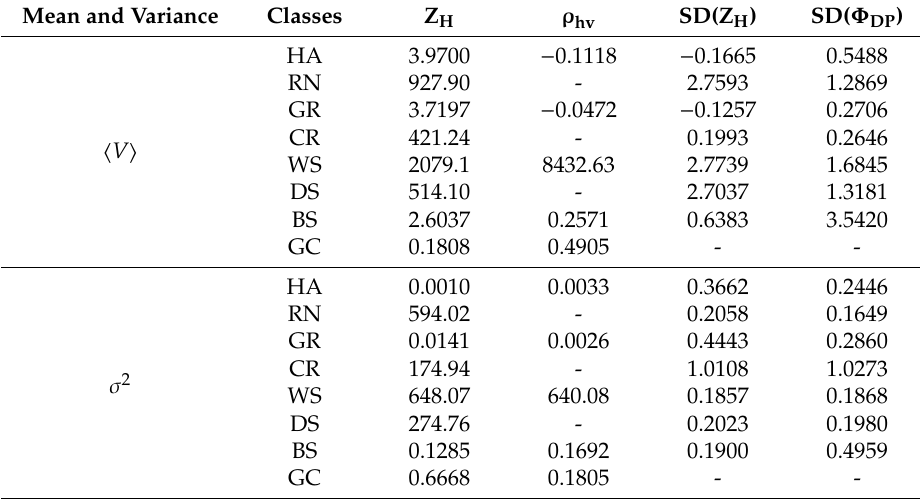
Table 2. Mean (cid:104) V (cid:105) , and variance σ 2 of four variables Z H , ρ hv , SD(Z H ) and SD( Φ DP ) and eight classes in Equations (3) and (4). The en-dash indicates that the fitting function is Equation (5) without mean and variance. Values given are the square (for Equation (3)) and the natural logarithm (for Equation (4)) of Z H [dBZ], Φ DP [degrees], and ρ hv .